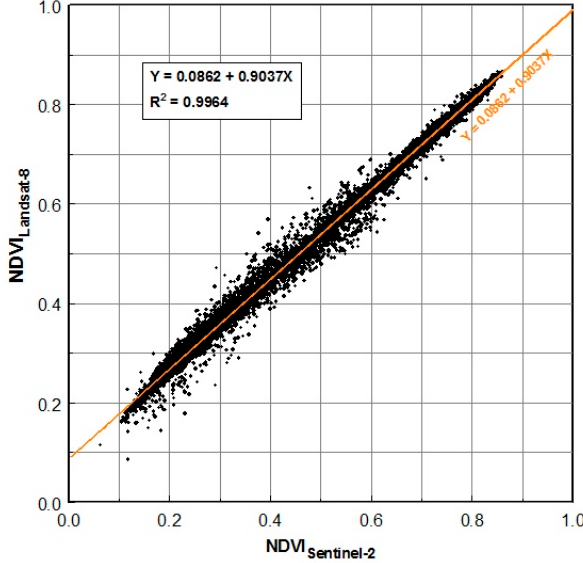
Figure 3. Inter-sensor NDVI comparison of Landsat-8 and Sentinel-2 using synchronous images of 23 Sep and 12 December 2016, covering the Goulburn-Murray Irrigation District.